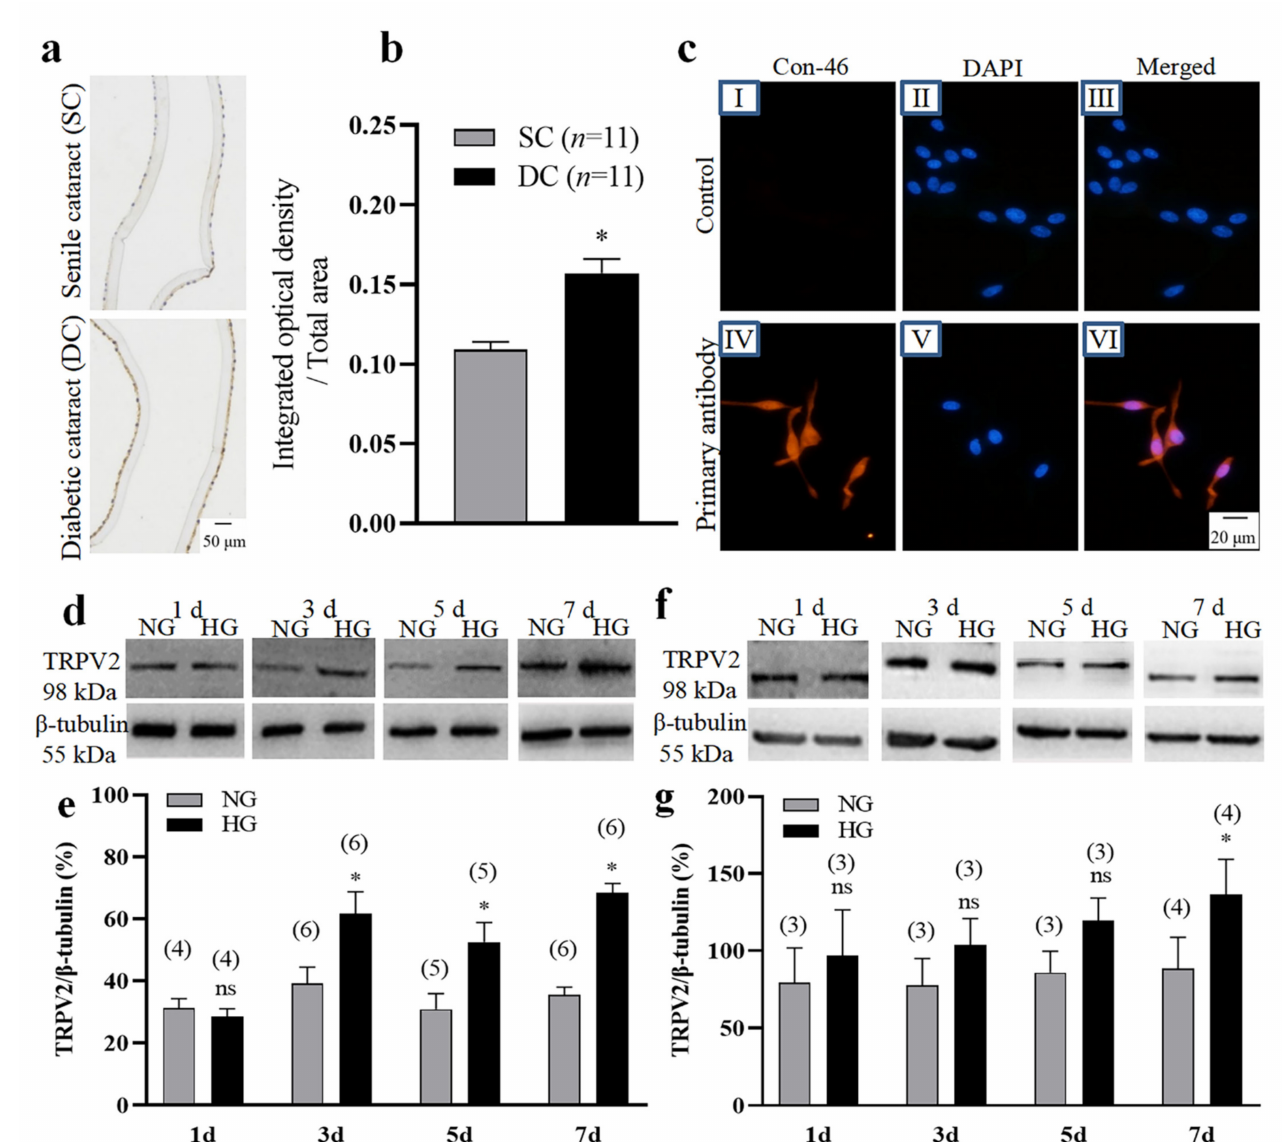
Figure 1. Changes in TRPV2 protein expression. ( a , b ) Representative images ( a ) and summary data ( b ) showing TRPV2 expression levels in human lens epithelial cells from patients having senile cataracts (SC) or diabetic cataracts (DC). In ( b ), data showing the ratio of integrated optical density/total area of TRPV2. ( c ) Immunofluorescence images showing the expression of connexin-46 (Con-46) protein in primary cultured lens epithelial cells from rat. No—primary antibody control: I–III Connexin-46 expression: IV-VI. Cell nuclei are stained blue by 4 (cid:48) ,6-diamidino-2-phenylindole (DAPI). ( d – g ) Representative Western blotting images ( d , f ) and summary data ( e , g ) showing the expression levels of TRPV2 in HLEpiCs ( d , e ) and primary rat lens epithelial cells ( f , g ) cultured in a normal-glucose (NG, 5.5 mM glucose and 20 mM mannitol) or high-glucose (HG, 25.6 mM glucose) media for 1, 3, 5, and 7 days. Numbers in parentheses over the bars in panels ( e , g ) represent the number of biological replicates. Values are shown as the mean ± SEM; n = 3–11. * p < 0.05 vs. SC